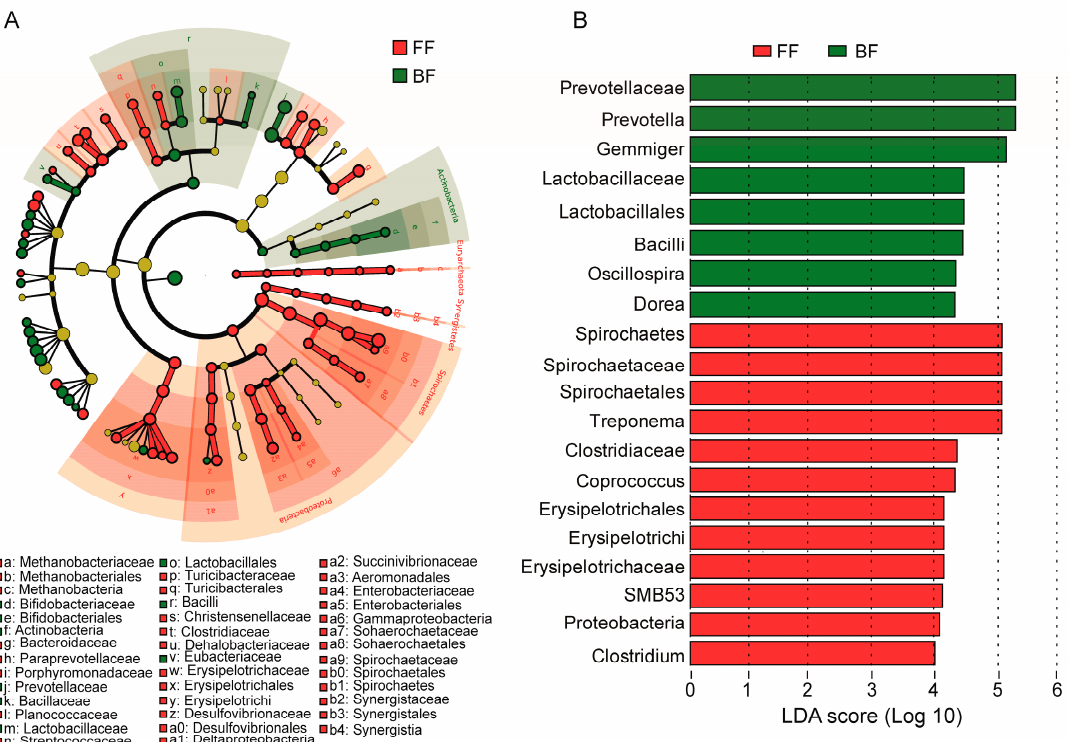
Figure 3. Microbial community composition: ( A ) Composition at the phyla level; ( B ) Relative abun- dance at the phyla level; ( C ) Composition at the genera level; ( D ) Relative abundance at the genus level.